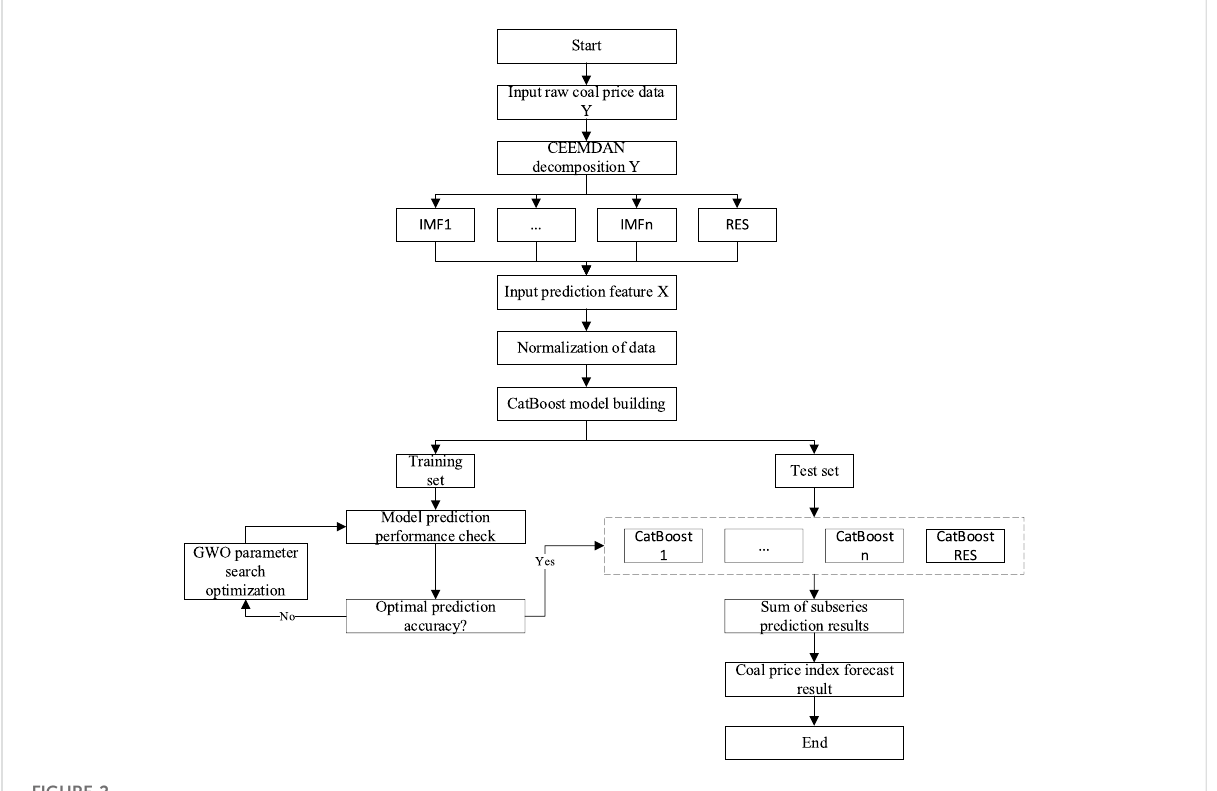
FIGURE 2 Flow chart of the coal price index forecasting model based on